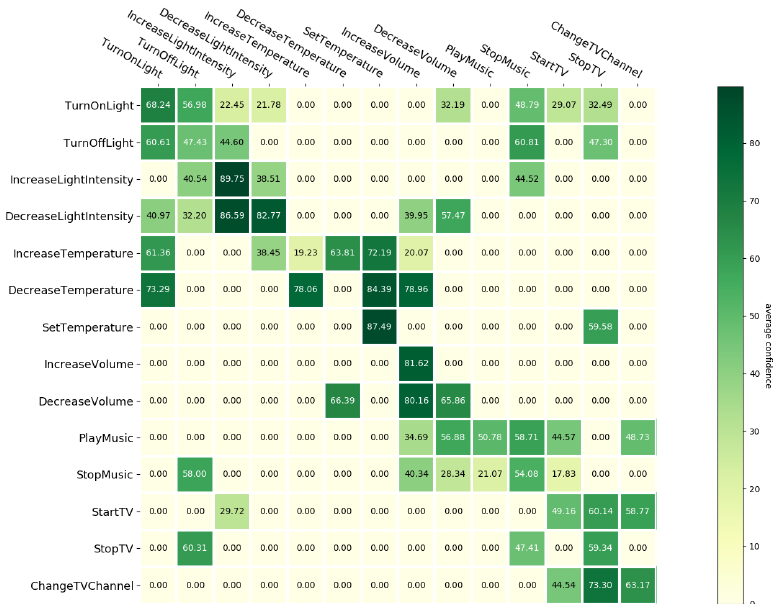
Figure A5. Confidence matrix for Scenario 3.3.